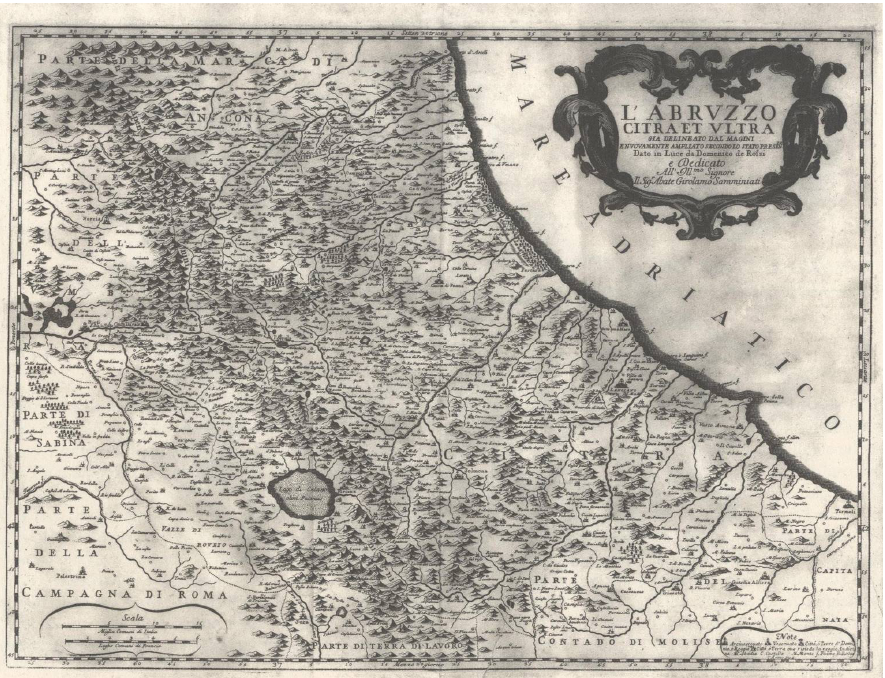
Figure 12. Domenico De Rossi, Abruzzo Citra et Ultra , Rome (1714), 540 × 433 mm, paper, Archives Collection of Pescara State (R. C. 3717).